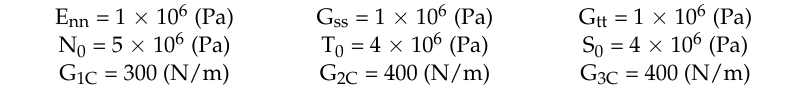
Table 2. Cohesion parameters of sandwiches with nap-core type P2-8 (adhesive thickness = 0.01